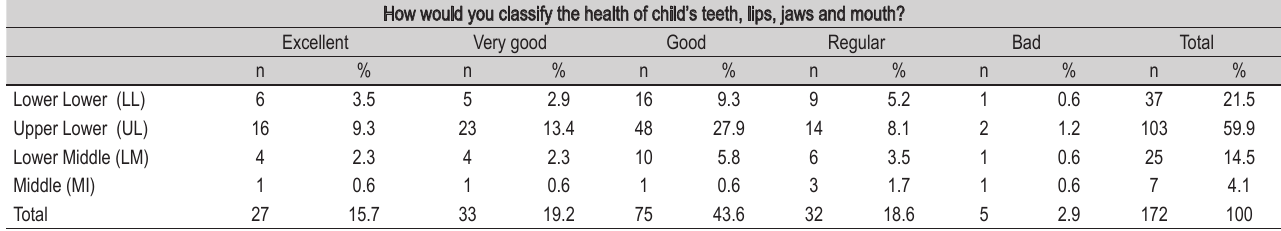
Table 1 - Number and percentage of parents or guardians with regards to the perception of their children’s oral health and socioeconomic classes, Américo de Campos/Pontes Gestal, Brazil, 2015.